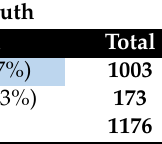
Table 2. Confusion Matrix Report based on IRI validation samples. Type-I errors (false positives; FP) are highlighted in blue while type-II (false negatives; FN) are shaded in red. Ground Truth Good